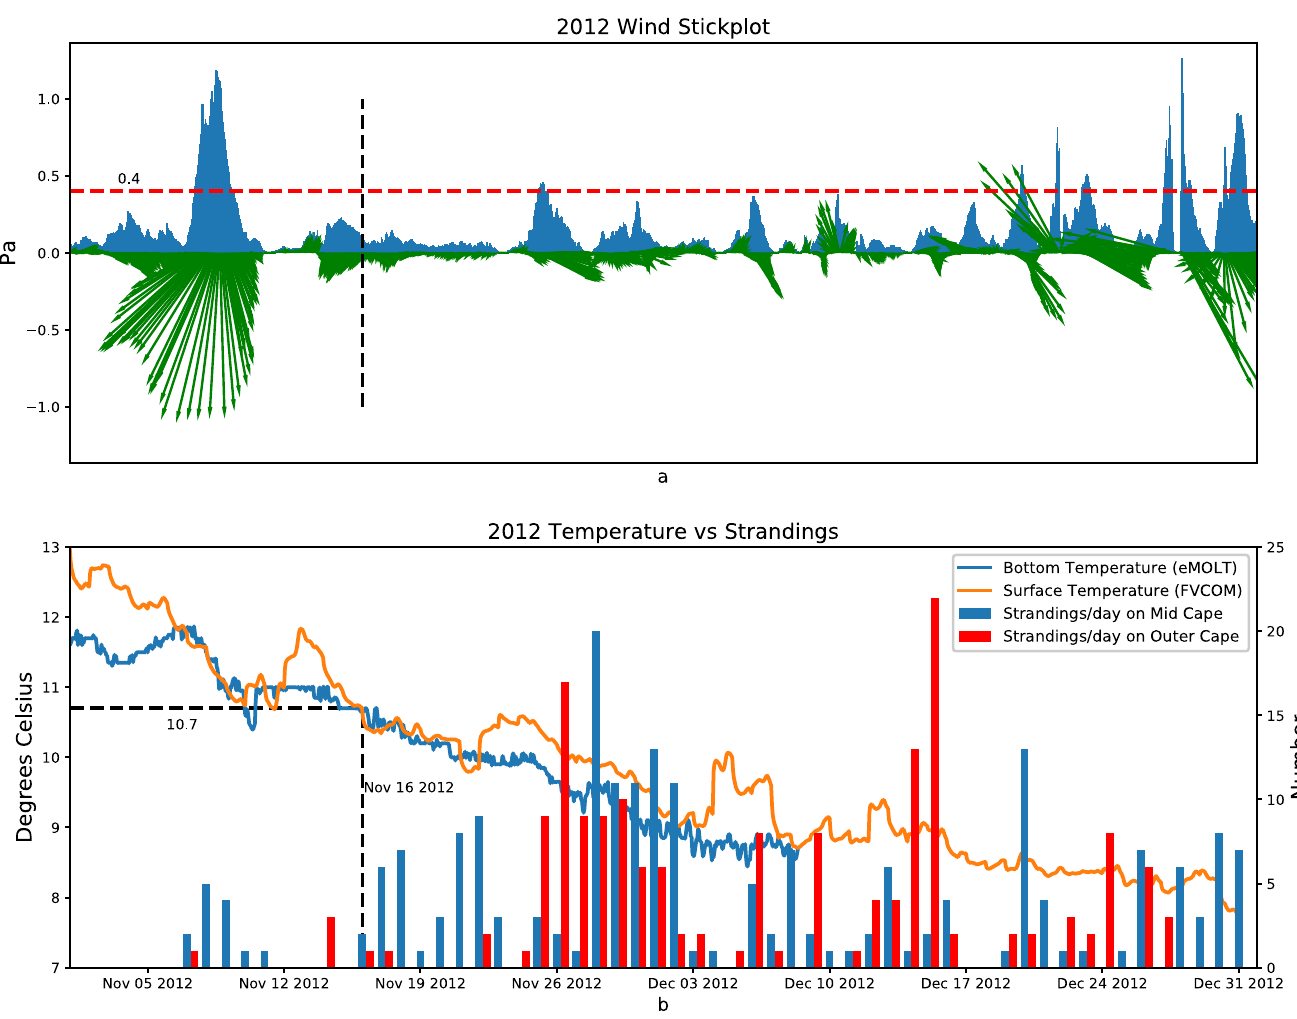
Fig 8. 2012: Top panel shows wind stress (Pa) direction shown in green vectors (north up) and magnitude in blue. The dashed red line represents the critical wind stress level of 0.4 Pa. Bottom panel shows Mid Cape strandings (blue bars) the Outer Cape strandings (red bars), modeled surface temperature (orange line), and observed bottom temperature (blue line) in